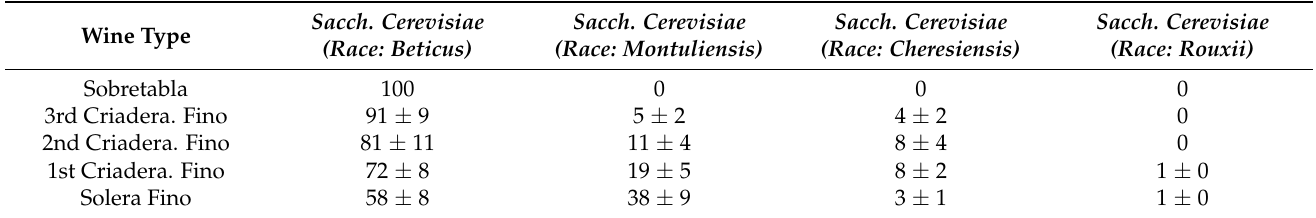
Table 6. Percentage composition (%) of flor yeasts in veil present in the biological aging of the Fino and Sobretabla wine studied